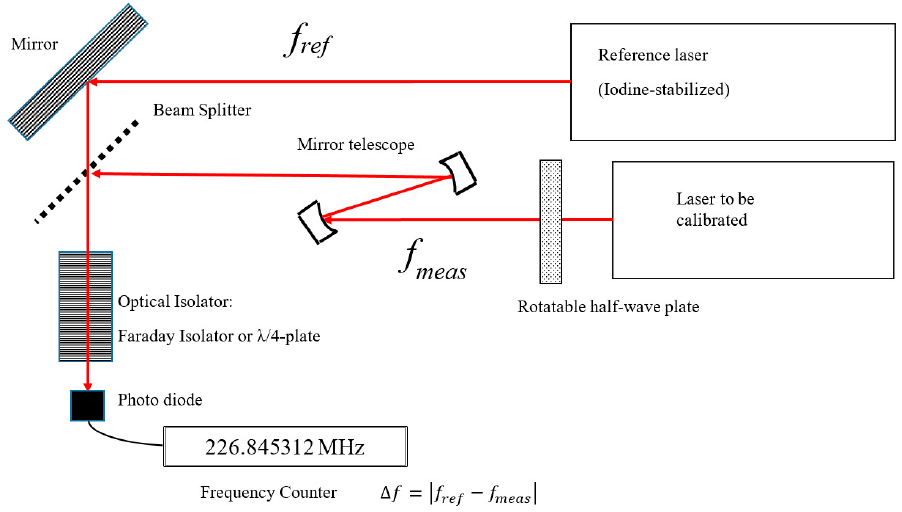
Figure 2. Scheme of a typical set-up for laser frequency calibration.